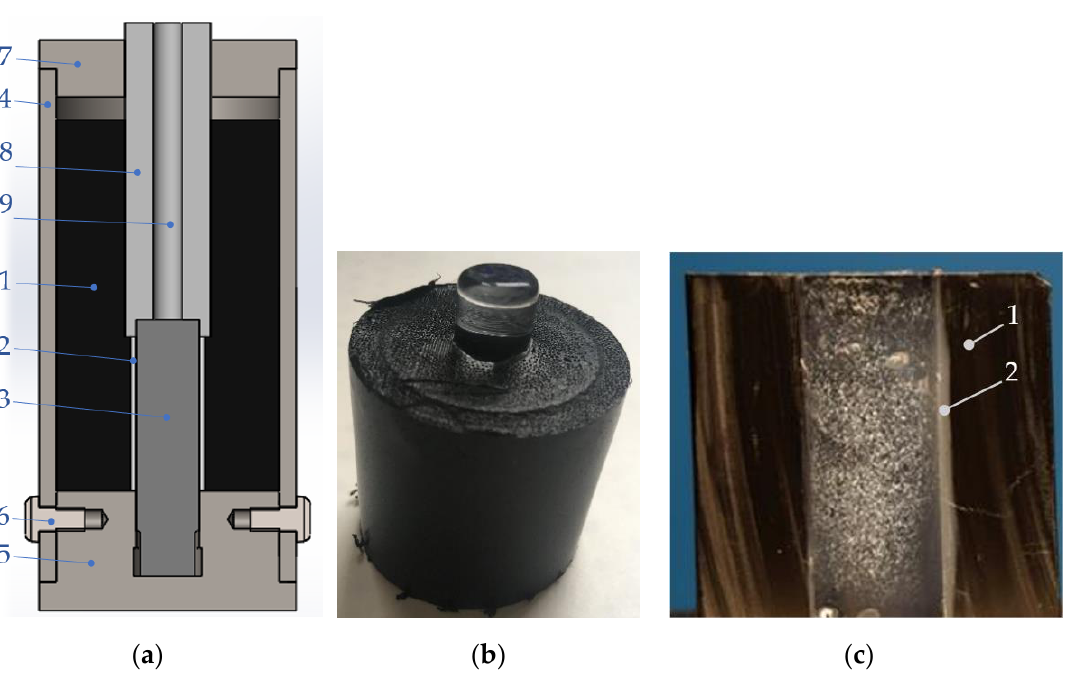
Figure 3. ( a ) Chrome-plated steel rod, diameter 12 mm; ( b ) glass rod, diameter 10 mm; ( c ) dip- coated rod; ( d ) sintered plastic layer; ( e ) cleared plastic layer; ( f ) use of silicone masking caps.